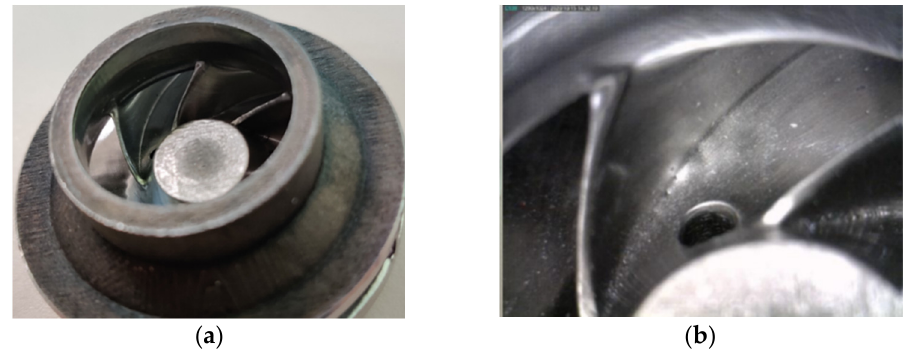
Figure 11. Images presenting the ( a ) closed impeller after AFM process and ( b ) close view of the finishing process.